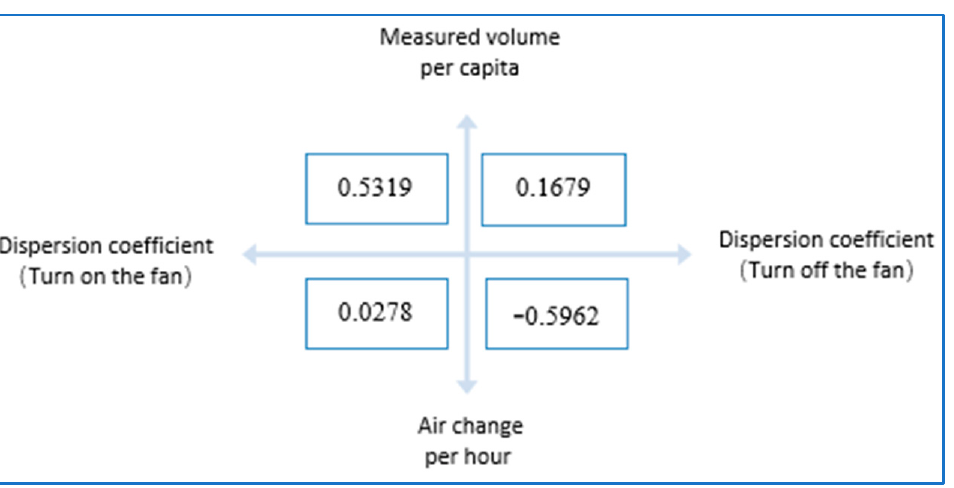
Table 7. Dispersion coefficient K C at various experimental conditions.